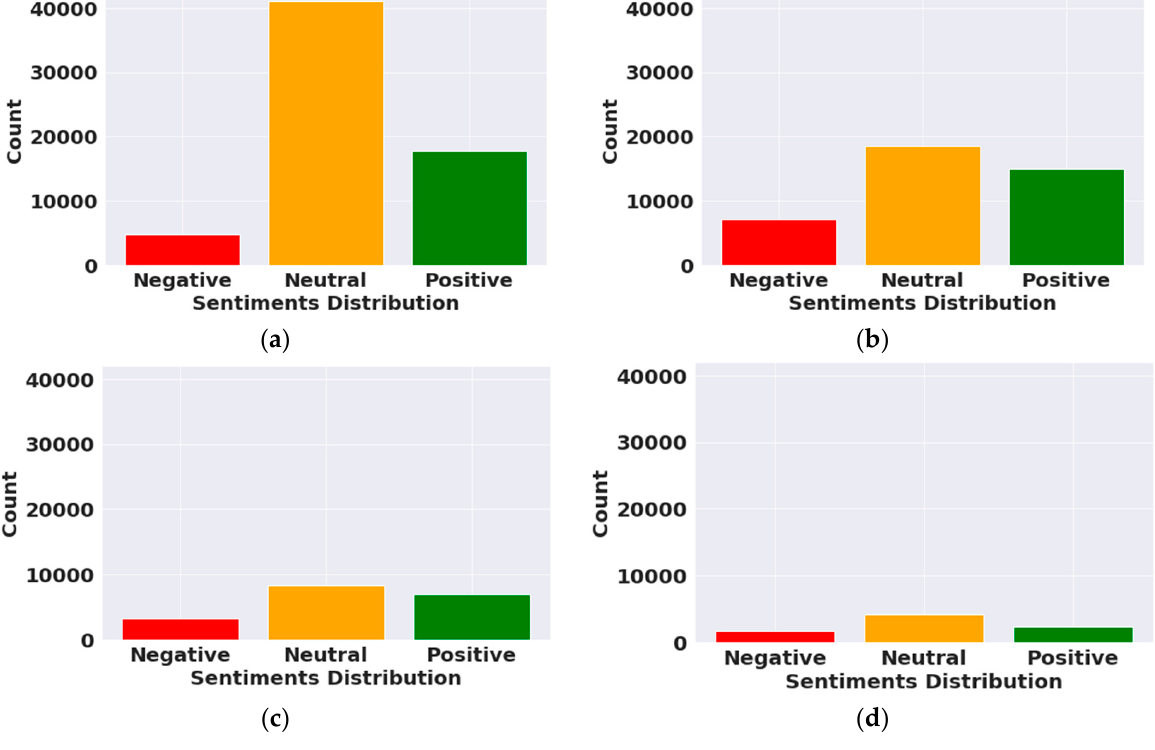
Figure 1. Distribution of COVID-19 vaccine sentiments: ( a ) Sentiment distribution of Covaxin; ( b ) sentiment distribution of Moderna; ( c ) sentiment distribution of Pfizer; ( d ) sentiment distribution of